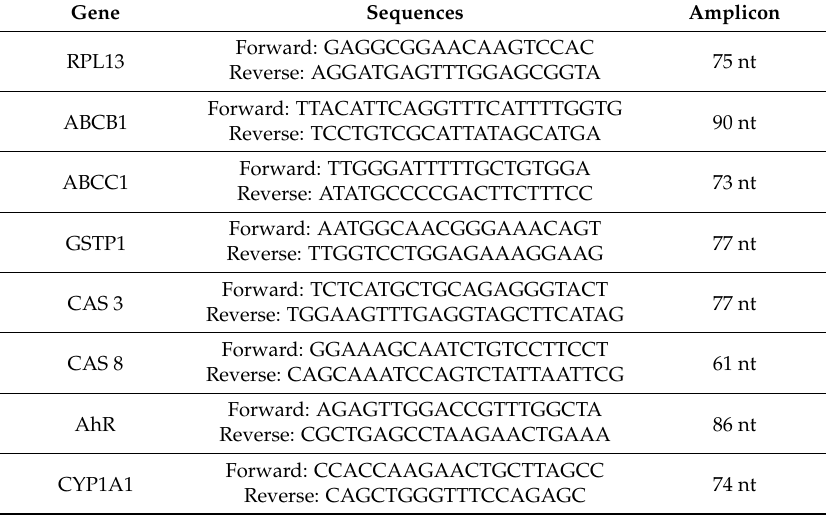
Table 1. Primers used in this study for